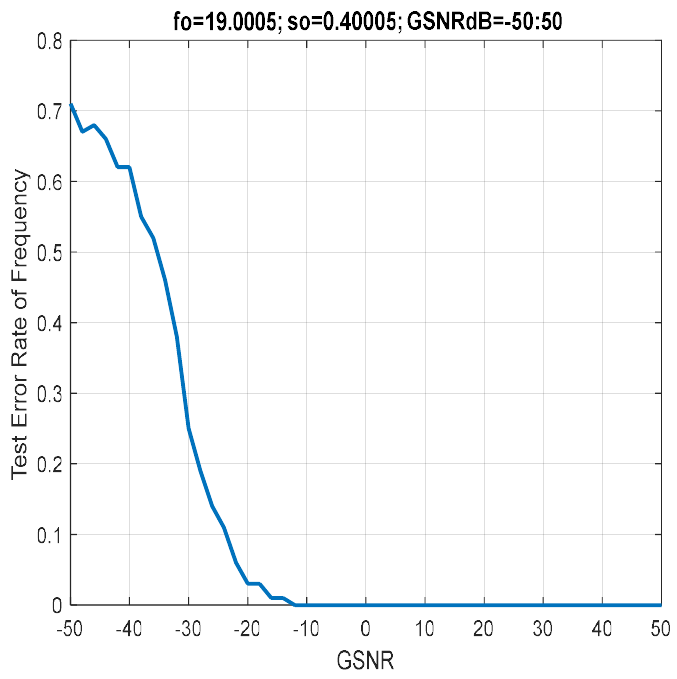
= 19.0005. (cid:3042)